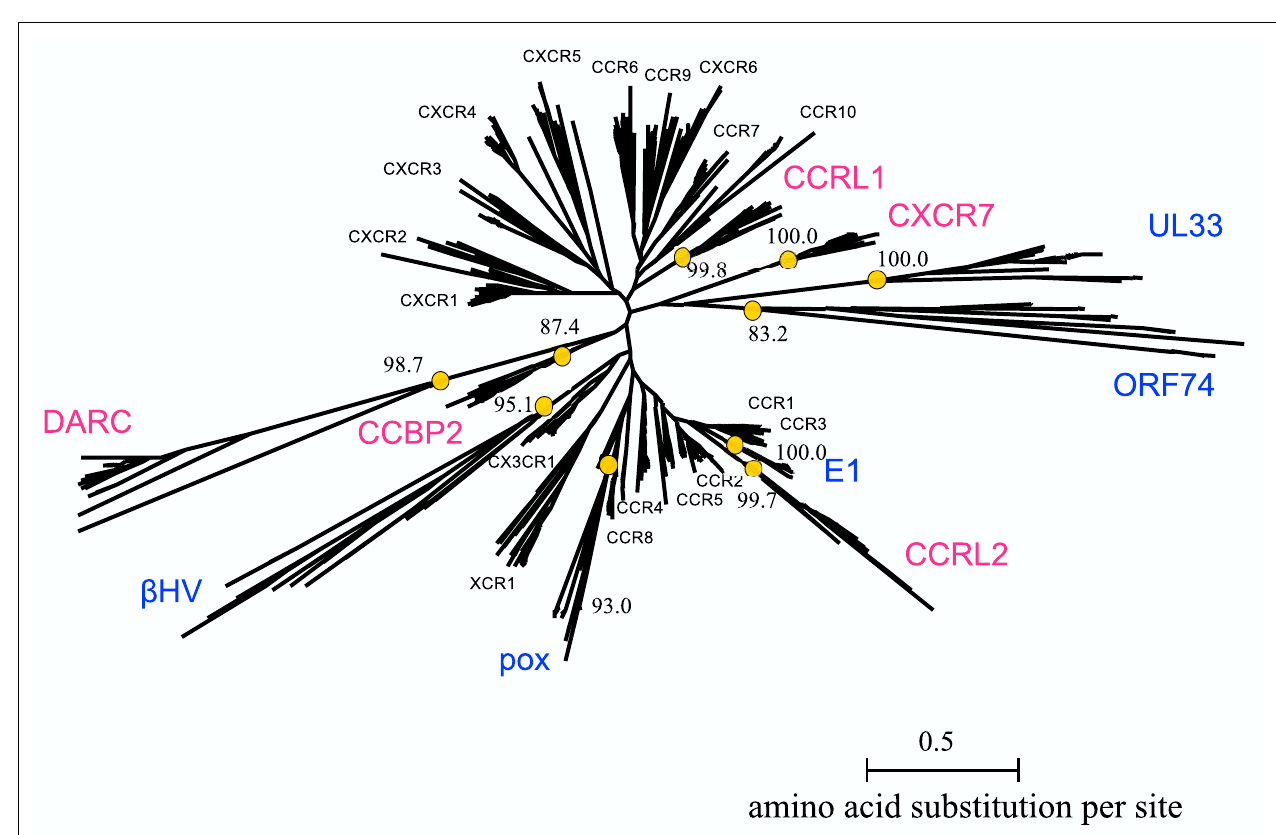
indicated near the receptor clusters.The bootstrap probabilities of the decoy and viral receptor groups are shown at the nodes corresponding to the common ancestors of the groups, which are indicated by